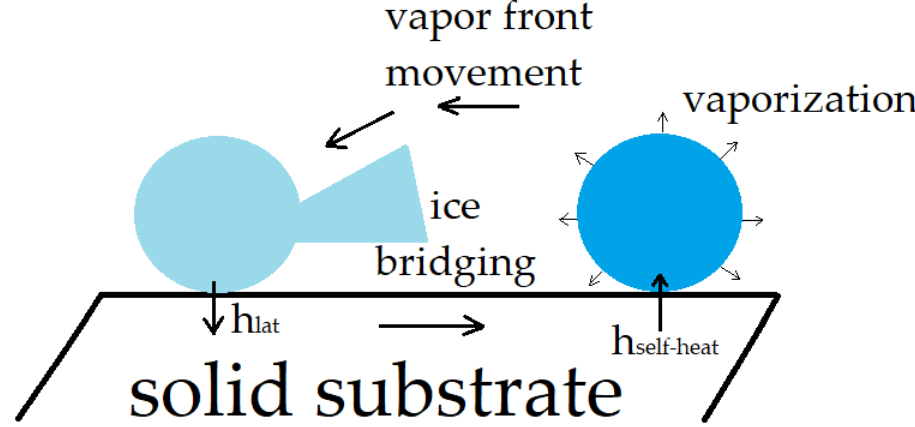
Figure 3. Scheme of collective droplet freezing, recreated using ref. [98].